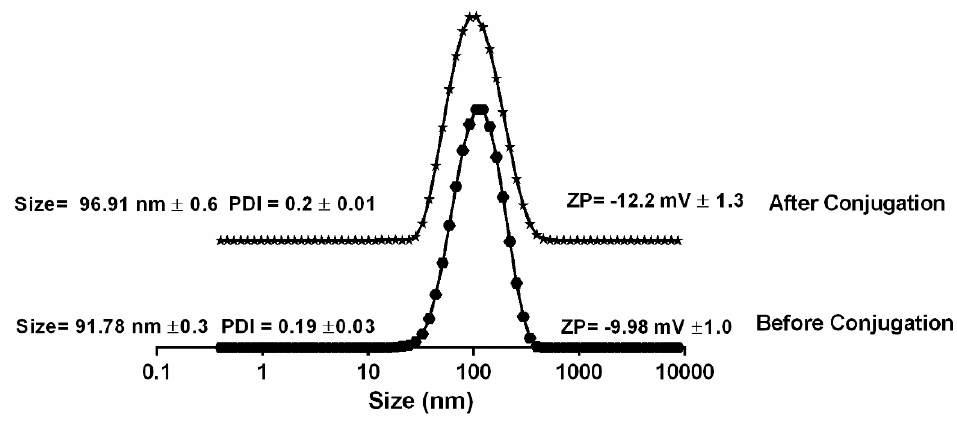
Figure 1. Dynamic light scattering (DLS) measurement of liposomes before and after RF-482 loading. ( n = 3 ± SD).